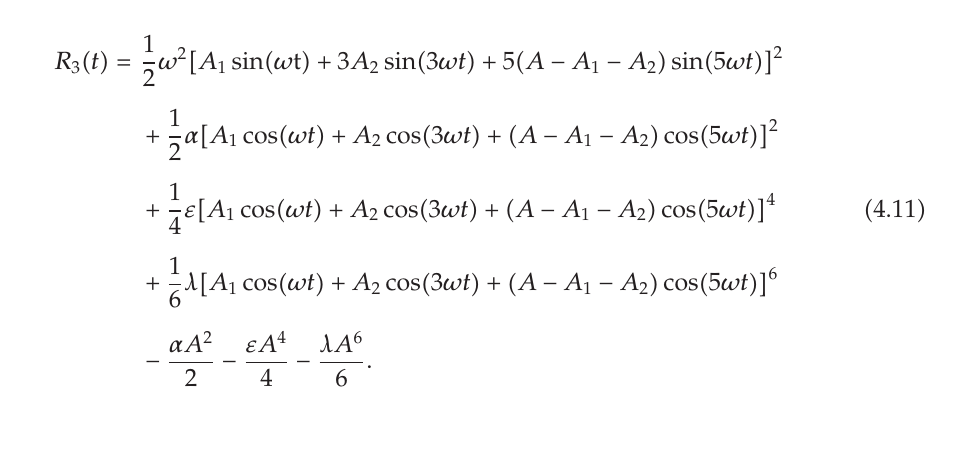
(cid:9) (cid:9) 8 α (cid:8) 6 εA 2 (cid:8) 5 λA 4 / Ref . (cid:6) 4 (cid:7)